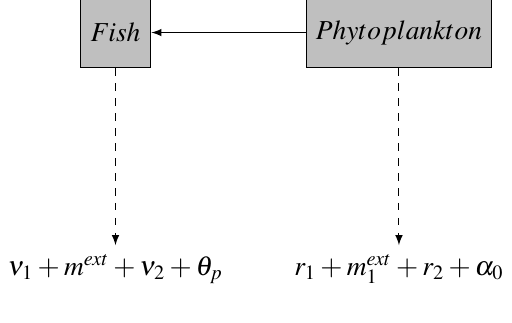
Figure 1. Typical ecological situation presented by toxin- producing phytoplankton-fish food-chain